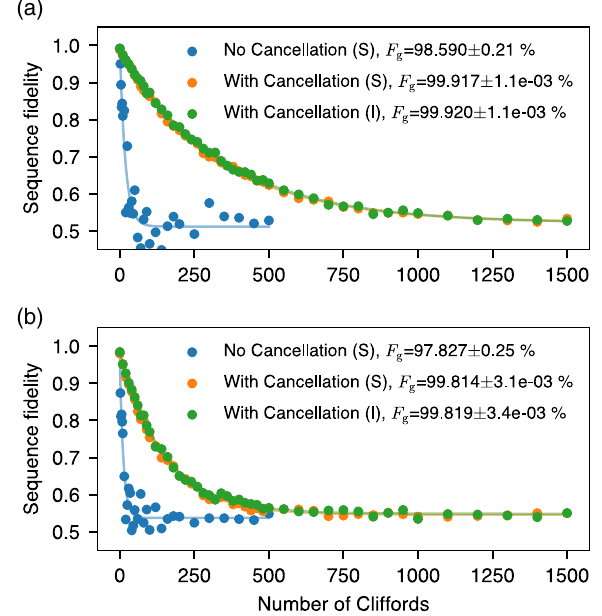
FIG. 24. Experimental results of single-qubit randomized benchmarking, when QB1 and QB2 are in resonance. (a) Sin- gle-qubit RB measurement data for QB1. (b) Single-qubit RB measurement data for QB2. S denotes the simultaneous appli- cation of single-qubit Cliffords, and I denotes the isolated application of single-qubit Cliffords. The pulse duration of X - and Y -rotation gates is 70 ns. Both QB1 and QB2 are biased at 4.16 GHz. We apply cancellation pulses to offset microwave cross talk (orange and green circles) and reduce the gate errors by more than a factor of 10. The data are averaged over 20 random sequences for each sequence